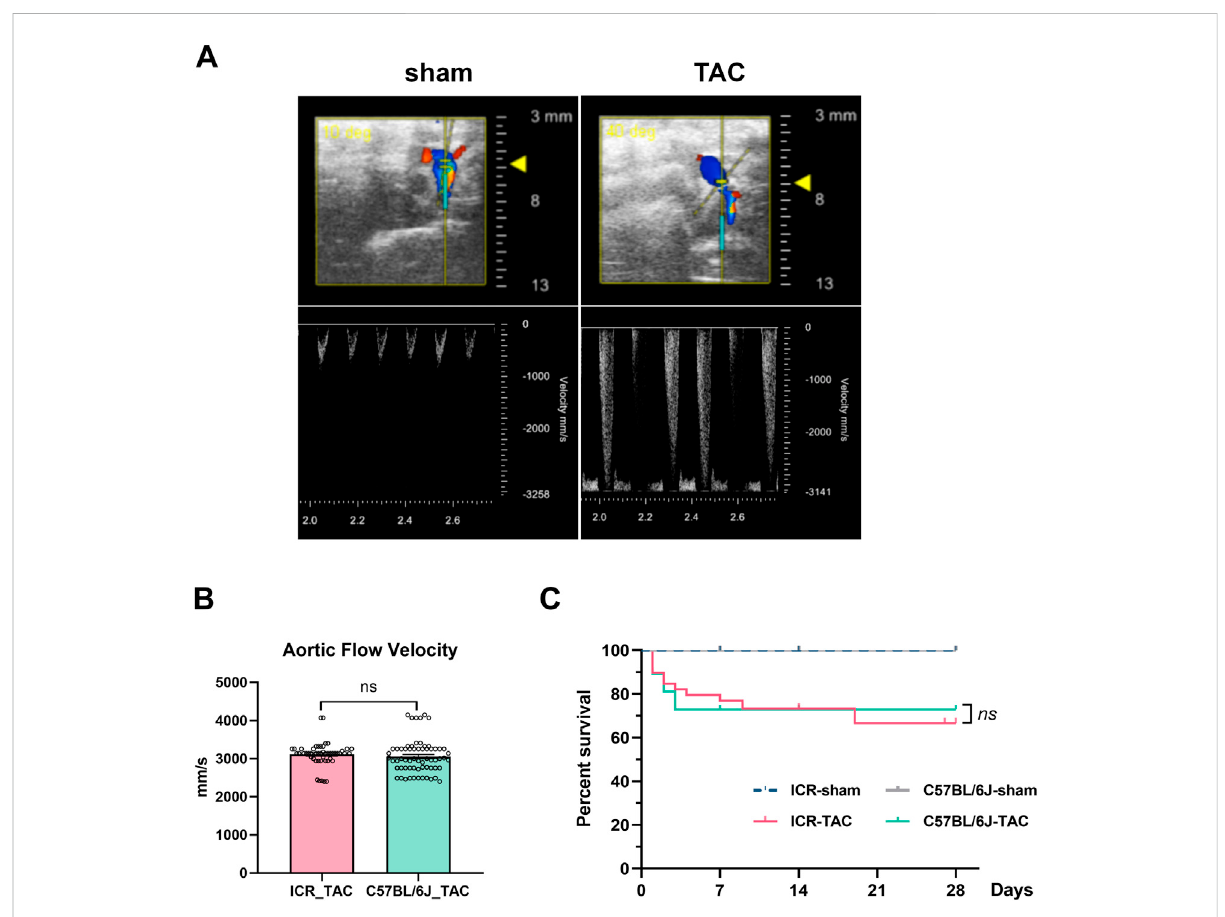
FIGURE 1 Survival after transverse aortic constriction (TAC) in ICR and C57BL/6J mice. (A) Representative Doppler fl ow velocity waveforms (lower panel)